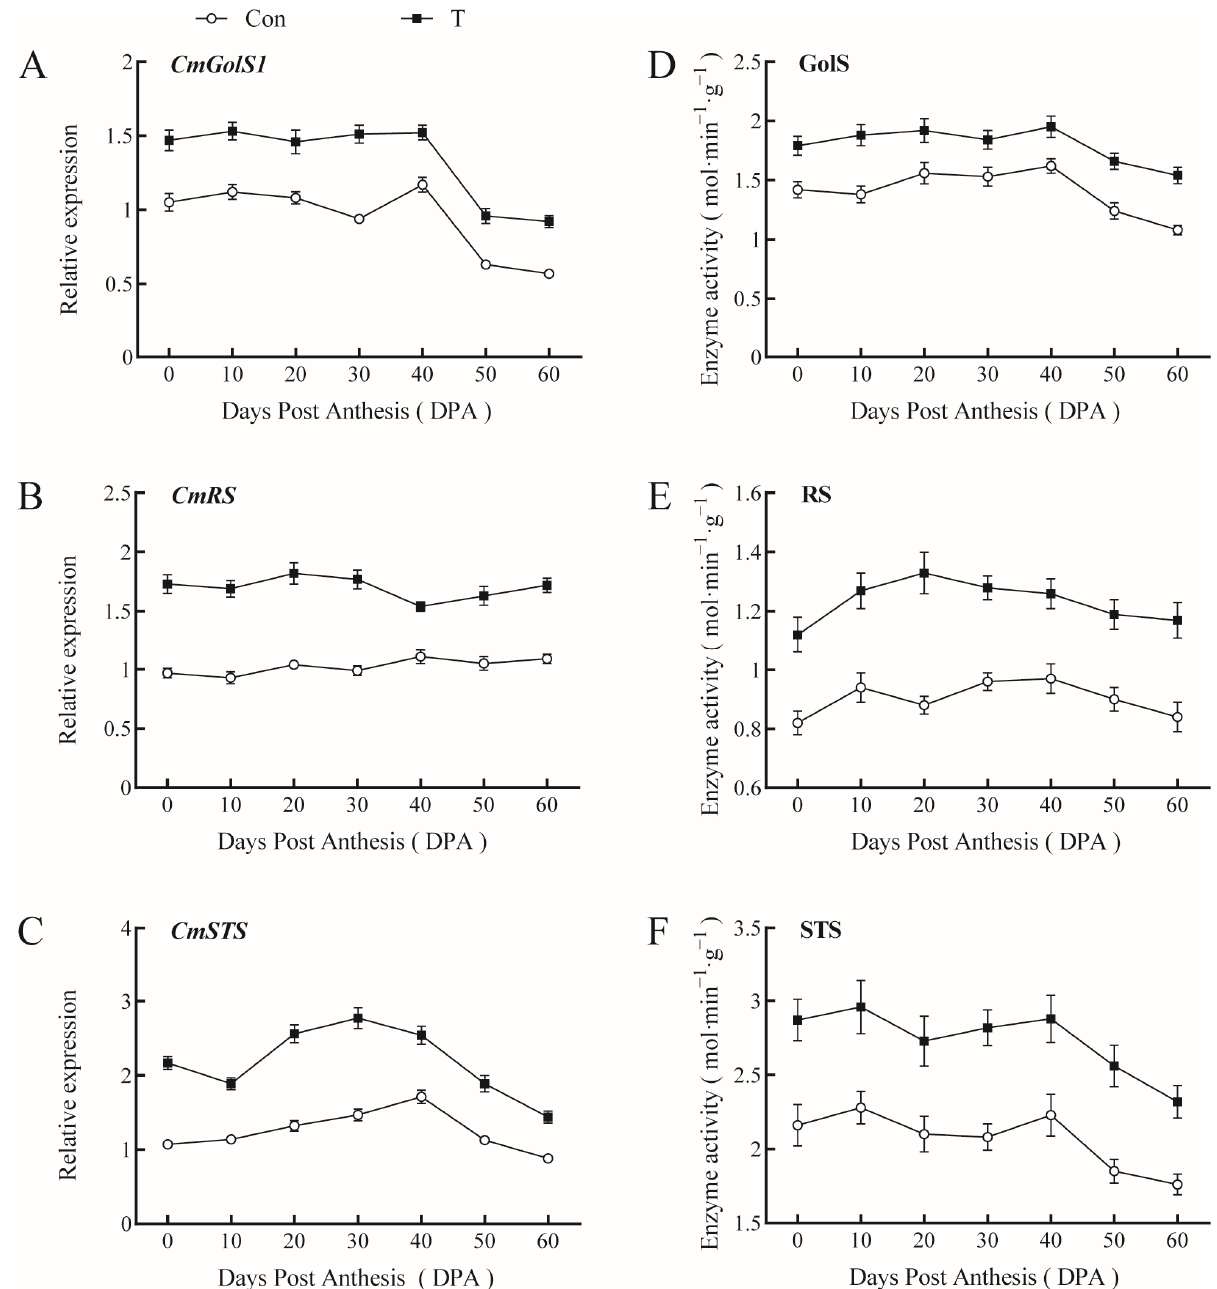
Figure 4. Effects of NAA and EBR on sugar-metabolism-related gene expression and enzyme activities in giant pumpkin leaves. ( A – C ) Relative expression levels of CmGolS1 , CmRS , and CmSTS ; ( D – F ) Activities of GolS, RS, and STS.